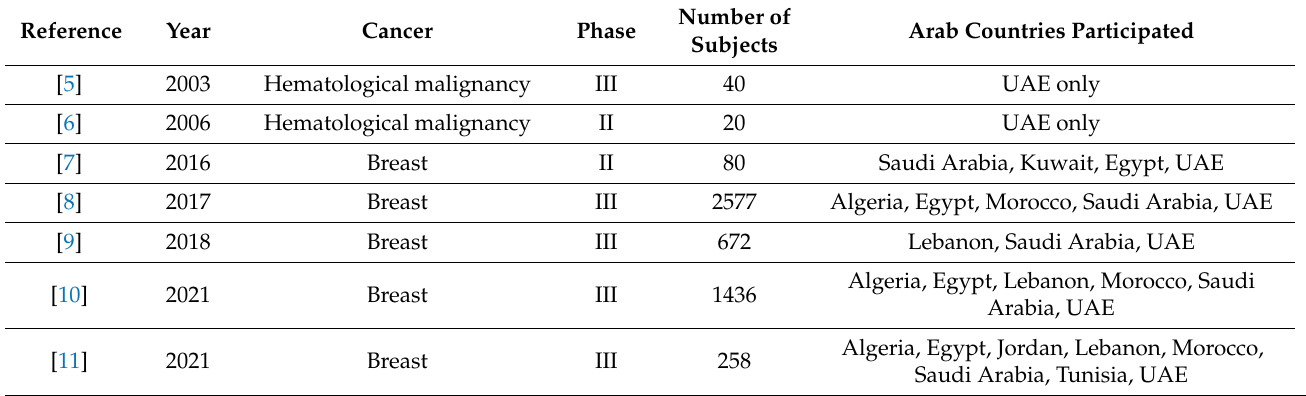
Table 1. Clinical trials in cancer indications conducted in the UAE. RCT, randomized, controlled